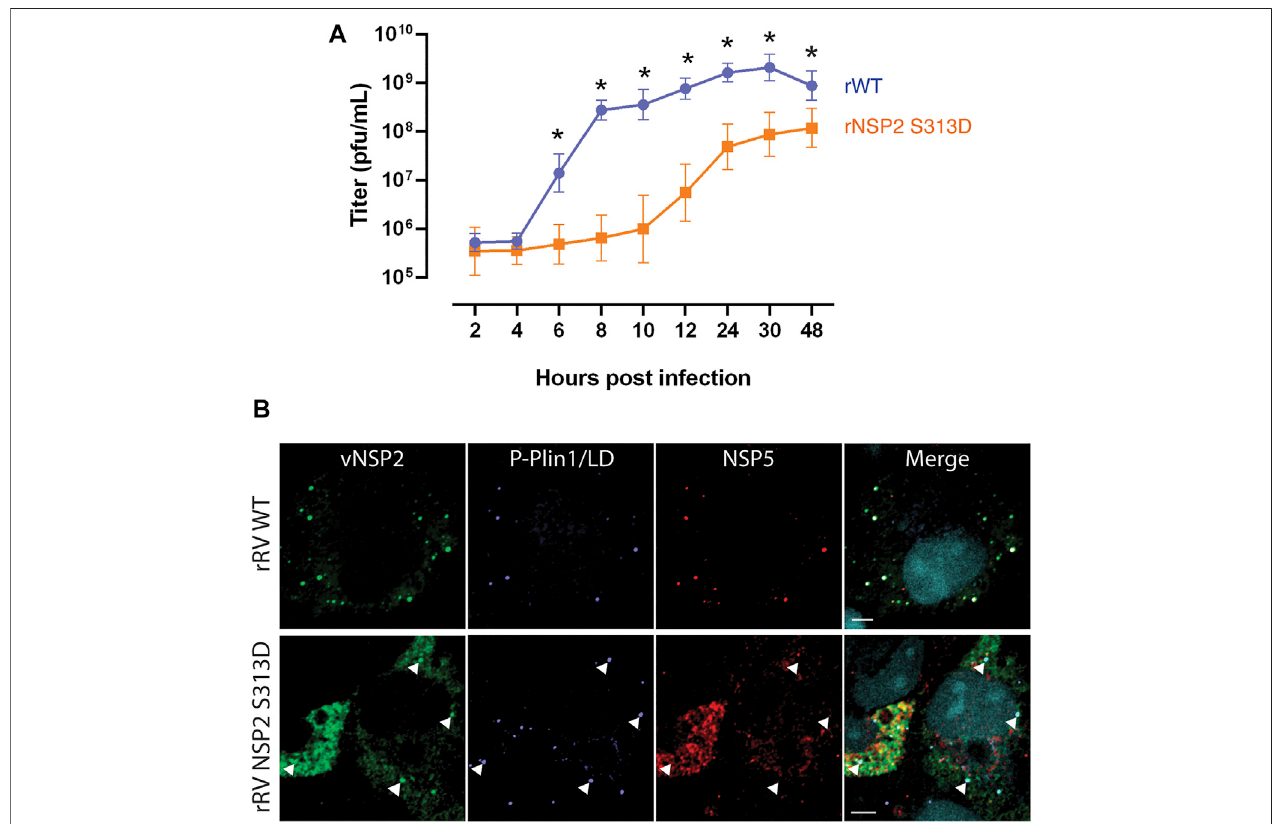
FIGURE 6 | vNSP2 expressed by the RV NSP2 S313D phospho-mimetic mutant virus colocalizes with nascent lipid droplets before association with NSP5. (A) Growth curves of recombinant RV (rRV) wild type compared to phosphomutant rRV NSP2 S313D virus showing the delay in virus replication as a consequence of delayed viroplasm formation. (B) Representative images of MA104 cells infected with rRV WT (top panel) or rRV NSP2 S313D (bottom panel) virus at 4 hpi. vNSP2, P-PLIN1,and NSP5 colocalize inrRV WT-infected cells; whereas, inrRV NSP2 S313D virus-infected cellsvNSP2colocalizeswithRV-induced P-PLIN1 decorated lipid droplets before interacting with NSP5 (examples are indicated with white arrowheads). Scale bar = 5 µm vNSP2 was detected with mouse monoclonal antibody anti-vNSP2(green).Mouseanti-phospho-PLIN1(blue)wasusedtodetectlipiddroplets.NSP5detectedwithguineapigpolyclonalantibodyanti-NSP5(red).Nucleiwere detected with DAPI (light blue). Scale bar = 5 μ m [From Criglar et al., 2020 (Criglar et al., 2020)].